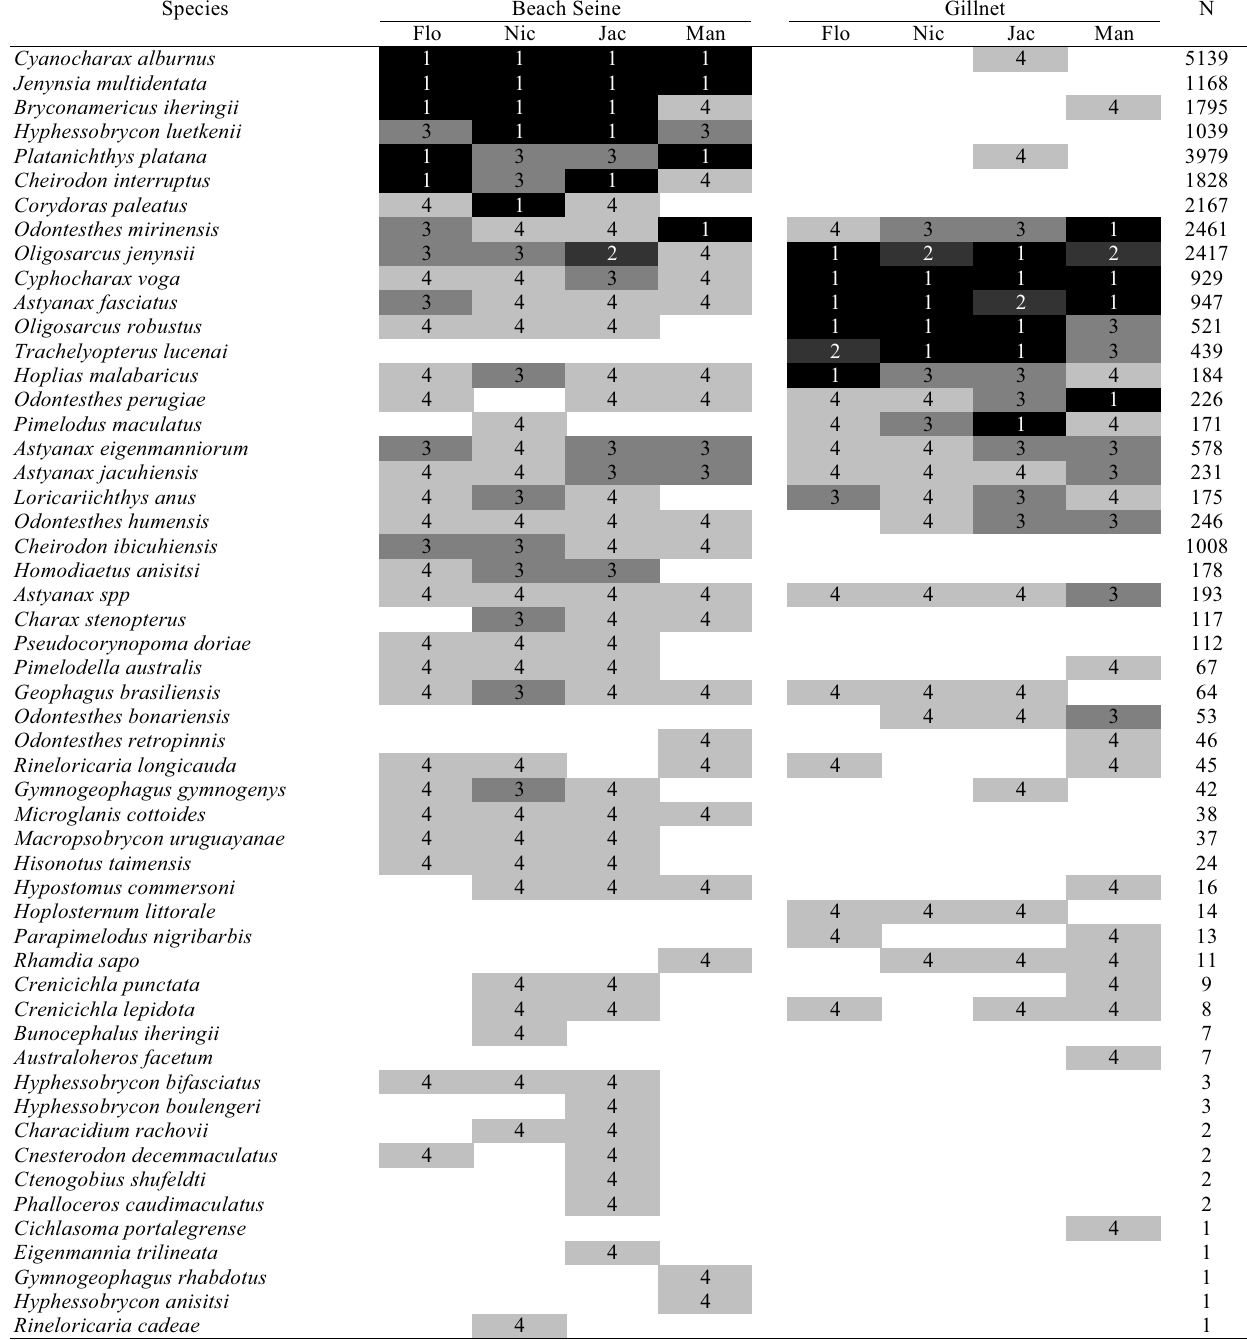
Table 2. Relative importance based on frequency of occurrence (%FO) and percent abundance (%CPUE) of the fishes captured from 2001 to 2005 in Taim’s lakes (Flores, Nicola, Jacaré and Mangueira Norte) by beach seine (shallow margins) and gillnet (pelagic waters) sampling. 1. High abundance and Frequent, 2. High Abundance and Rare, 3. Low abundance and Frequent and 4. Low abundance and Rare. See Materials and Methods for further details of categories (1-4).